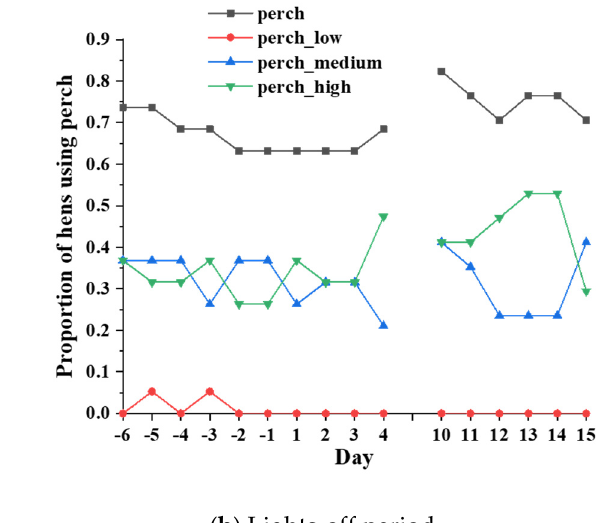
Figure 4. The proportion of laying hens using perches of low-, medium-, high-height, as well as overall levels, on all observation days during the lights-on ( a ) and lights-off ( b ) periods.